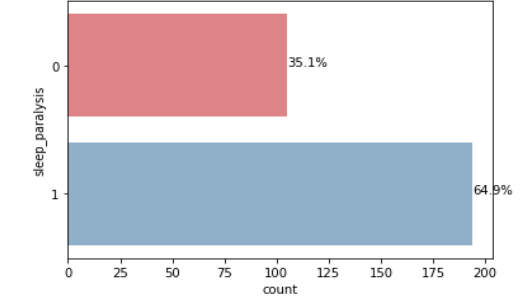
Figure 10. Sleep